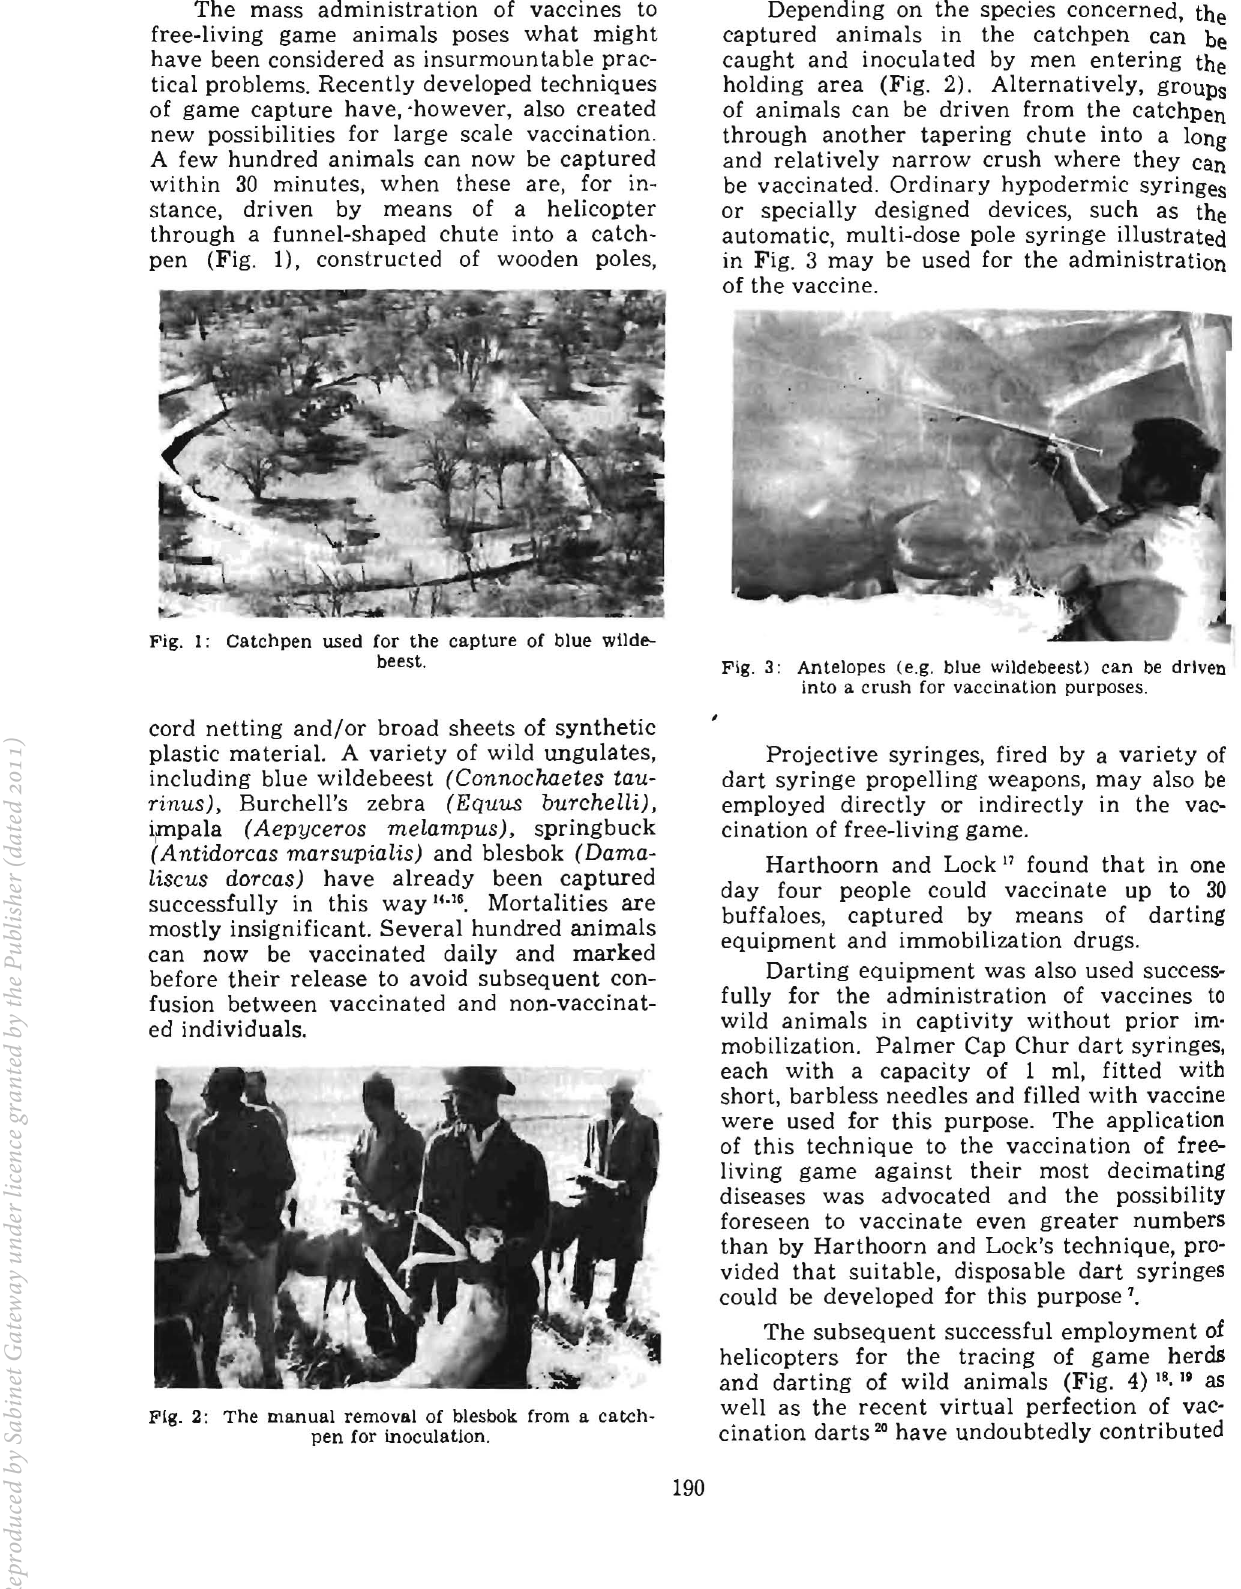
Fig. 2: The manual removal of blesbok from a catch pen for inoculation.